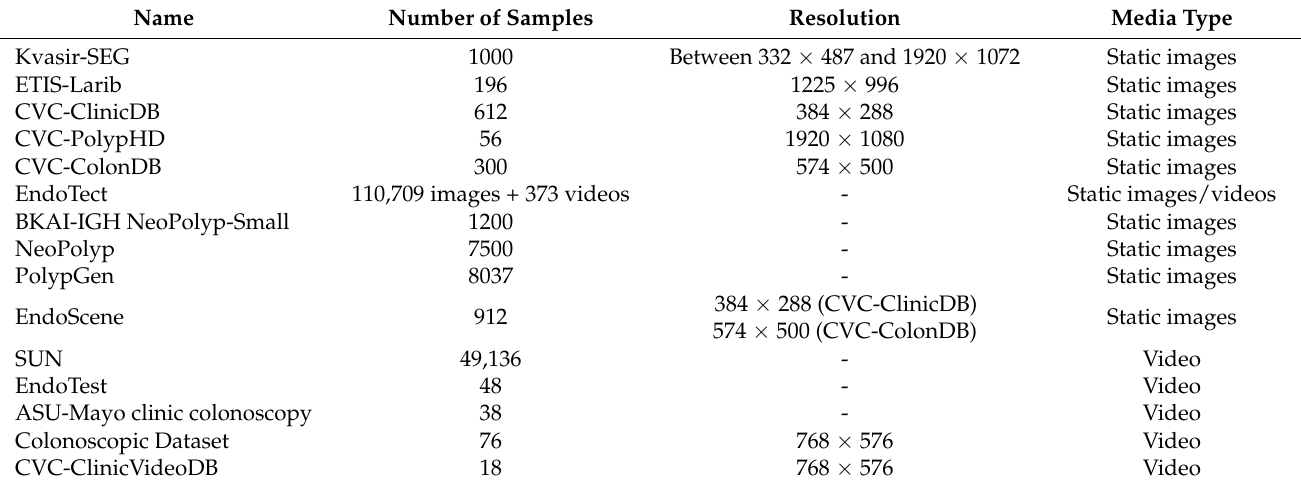
Table 2. A summary of the existing benchmark colonoscopy datasets.